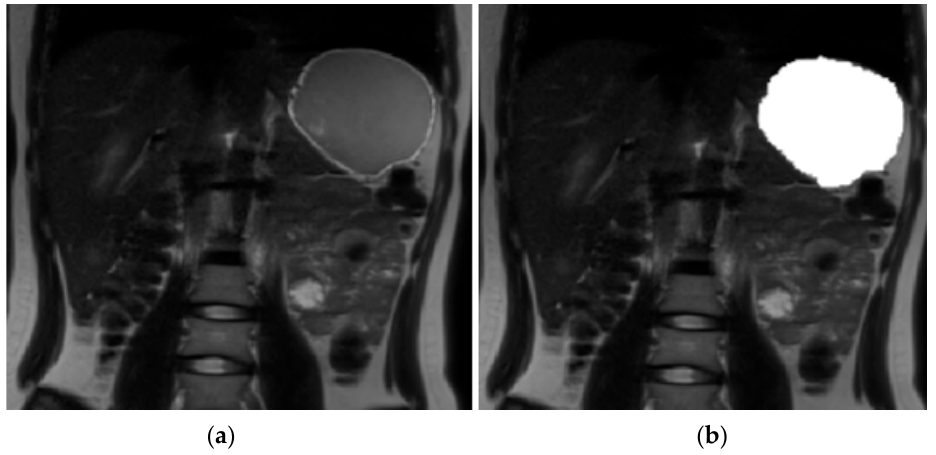
Figure 3. Image analysis using FMRIB’s Software Library (FSL v5.0.11). ( a ) Magnetic resonance image of the stomach 10 min after drinking milk. ( b ) Magnetic resonance image of the stomach with the mask of the milk content.